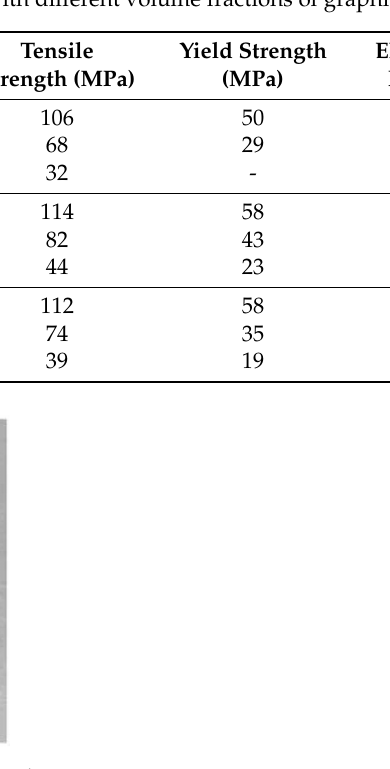
Figure 12. Tensile fracture morphology of